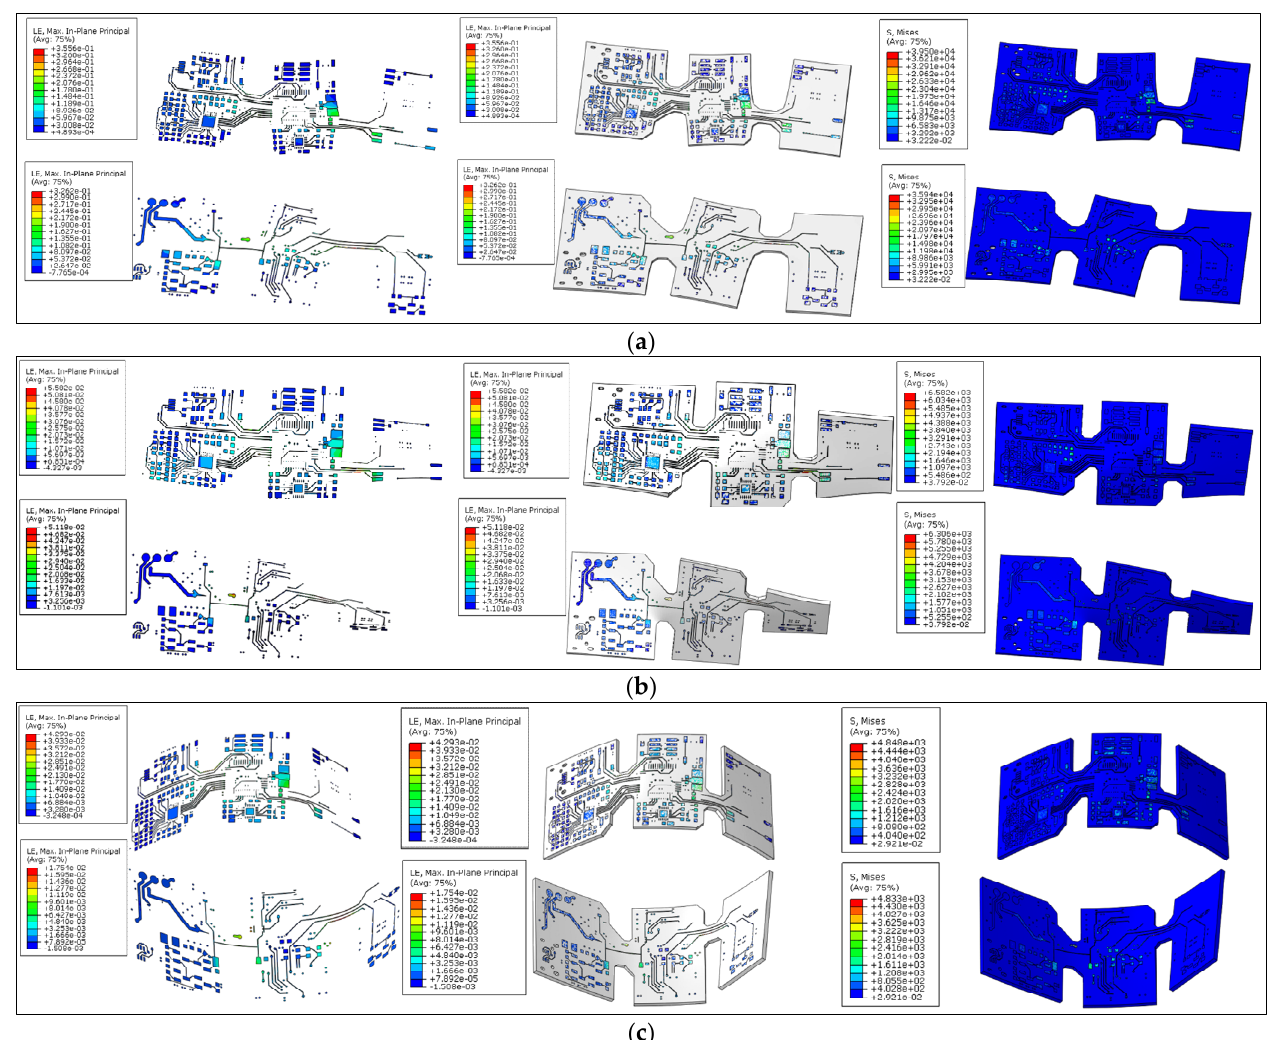
Figure 13. Hardware simulation diagram. ( a ) Tensile test: constrain one end and stretch the other end by 8 mm. ( b ) Torsion test: constrain one end and rotate the other end by 90 degrees (1.57 radians). ( c ) Bending test: bending jig restraint, both ends downward displacement of 15 mm.